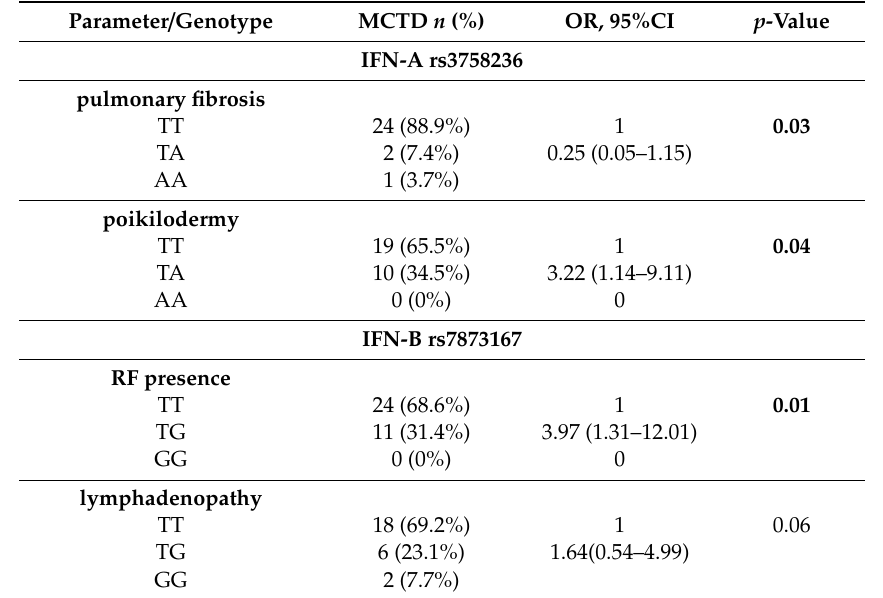
Table 5. Correlation between IFN-A, IFN-B, IFN-G genotypes (codominant model), and clinical pathology parameters in